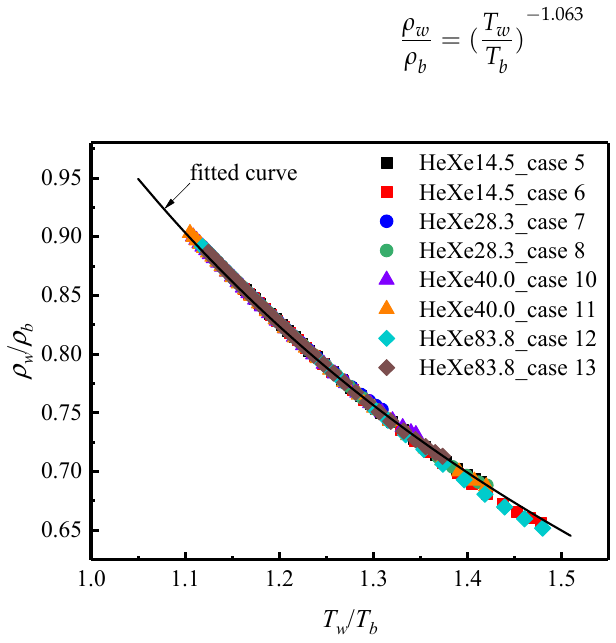
Figure 11. Variation of ρ w / ρ b with T w / T b for He–Xe.